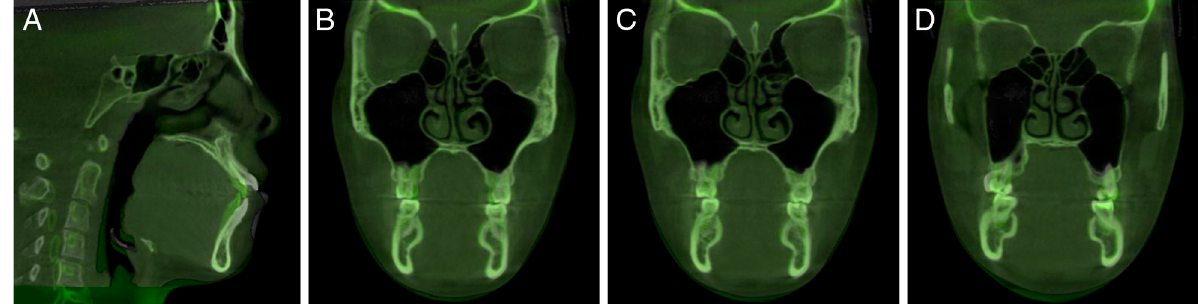
Figure 10. Three-dimensional (3D) superimpositions (pre-treatment and post-treatment). (A) the anterior teeth; (B–D) the posterior teeth.